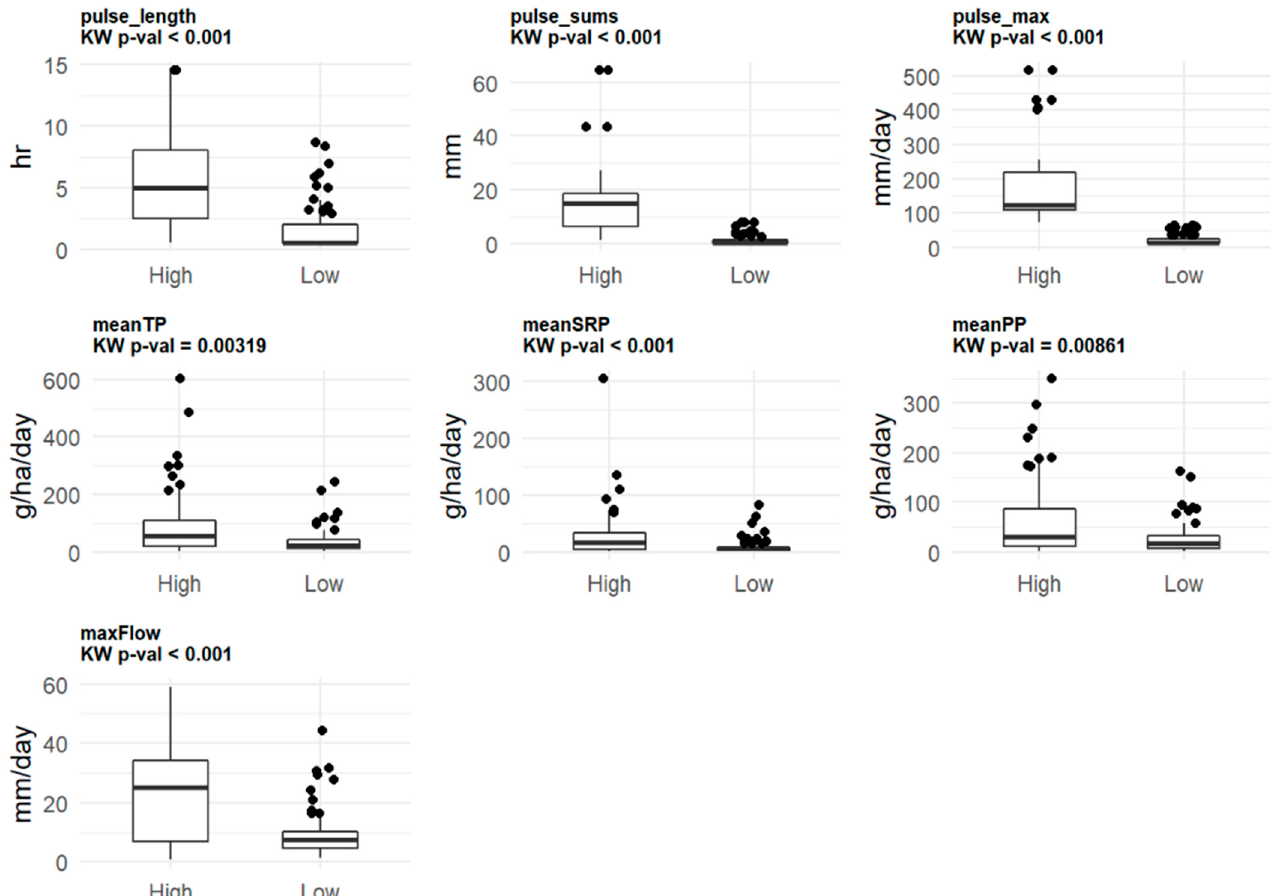
Figure 3. Boxplots showing the difference between pulse and TD discharge metrics for high and low-intensity pulses.